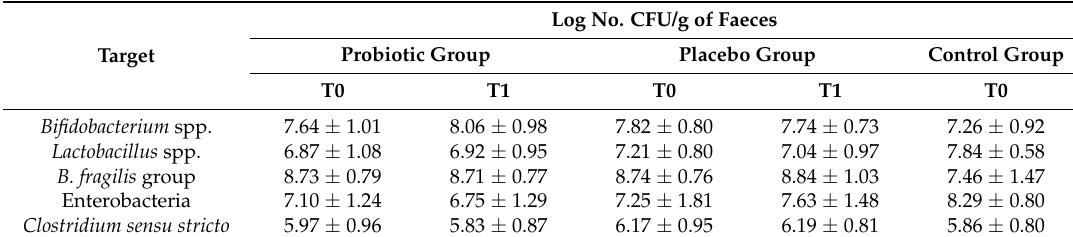
Table 3. Mean counts of different microbial groups analysed in stool samples expressed as Log CFU/g of